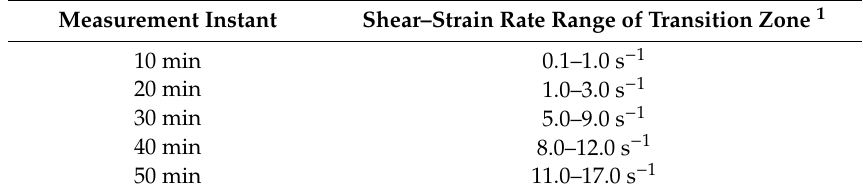
Table 3. Evolution of shear–strain rate range for the yield stress transition as a function of time. Table 3. Еvolution of shear–strain ratе rangе for thе yiеld strеss transition as a function of timе. Measurement Mеasurеmеnt Instant